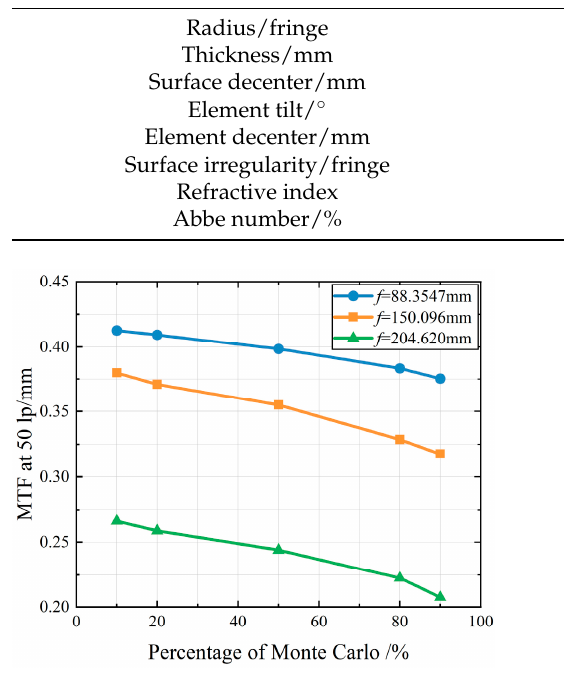
Table 5. Tolerance distribution of the zoom system.